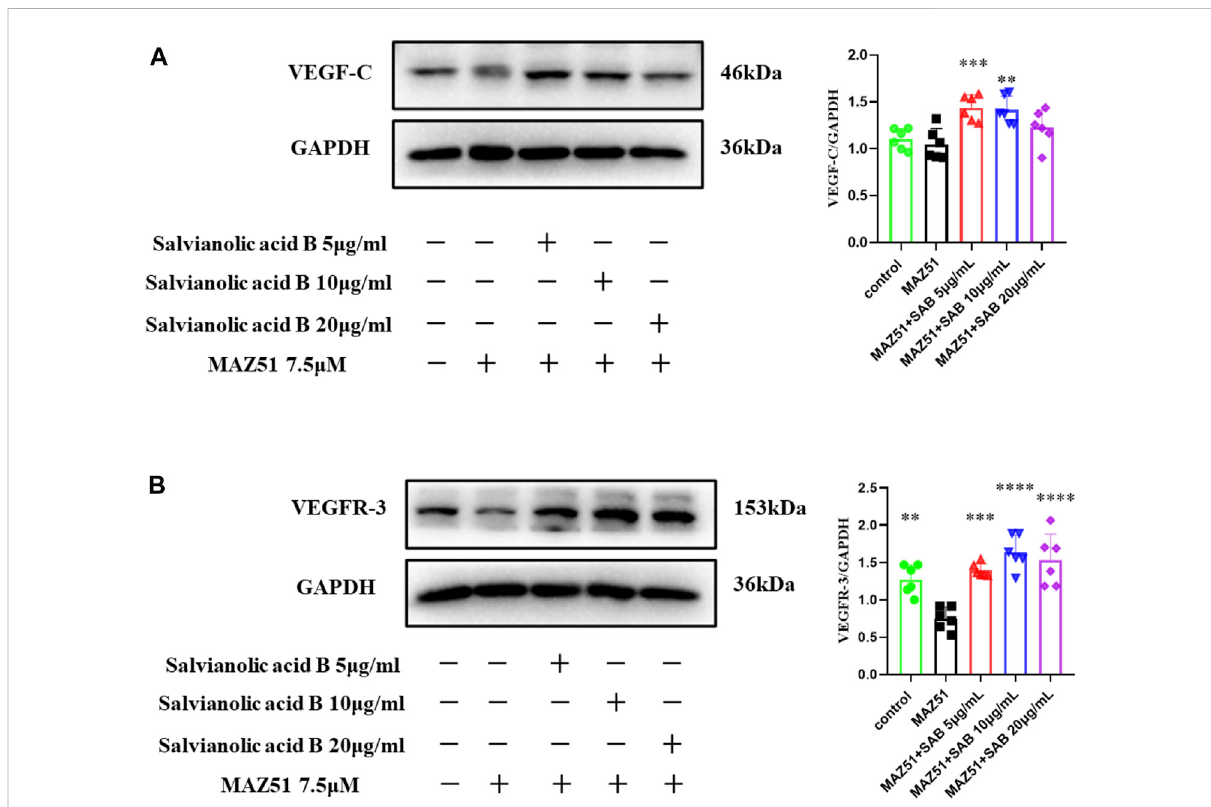
FIGURE 13 SalvianolicacidBpromotedtheproteinexpressionsofVEGF-CandVEGFR-3proteinsinlymphaticendothelialcellsunderinjury.AftertheLECs weretreatedwithMAZ51for24 htoinduceinjury,alongwiththetreatmentofthreedosagesofSABfor24 h,celllysateswerepreparedandanalyzed by western blot assay. (A) . Quantitation of the protein expression of VEGF-C. (B) . Quantitation of protein expression of VEGFR-3. ** p < 0.01 vs. MAZ51 group; *** p < 0.001 vs. MAZ51 group; **** p < 0.0001 vs. MAZ51